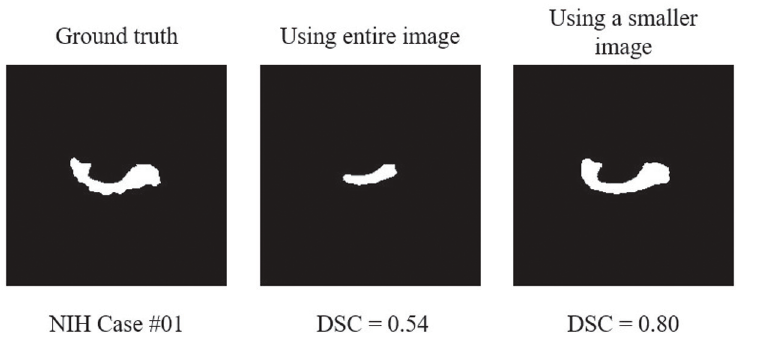
Fig 2. Illustration of the segmentation results of two different input regions. A smaller input region improves the segmentation performance.